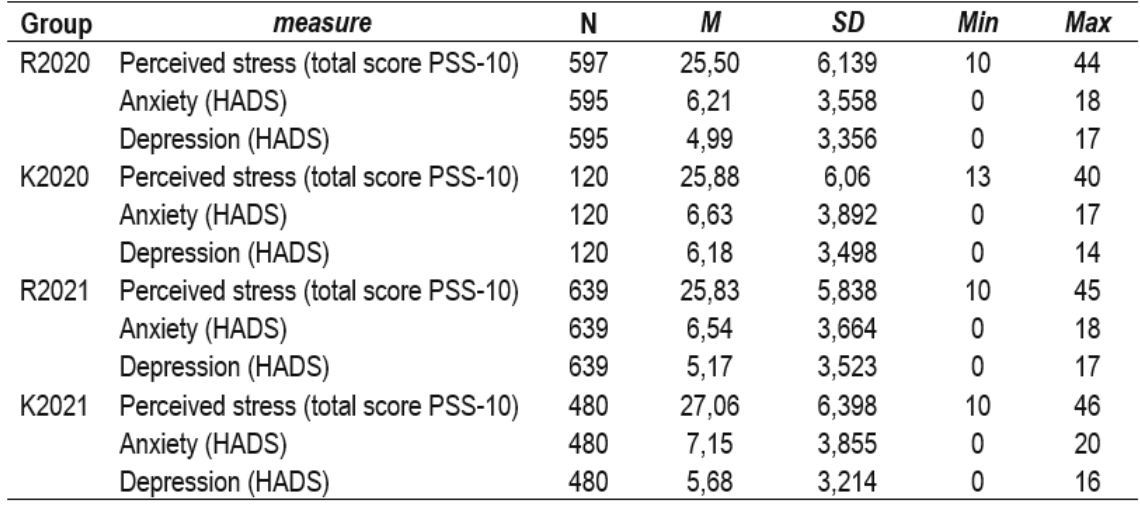
Descriptive statistics of anxiety, depression and perceived stress in 4